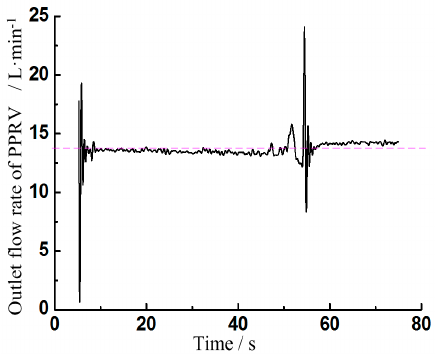
Figure 13. Flow rate out of the PRV.